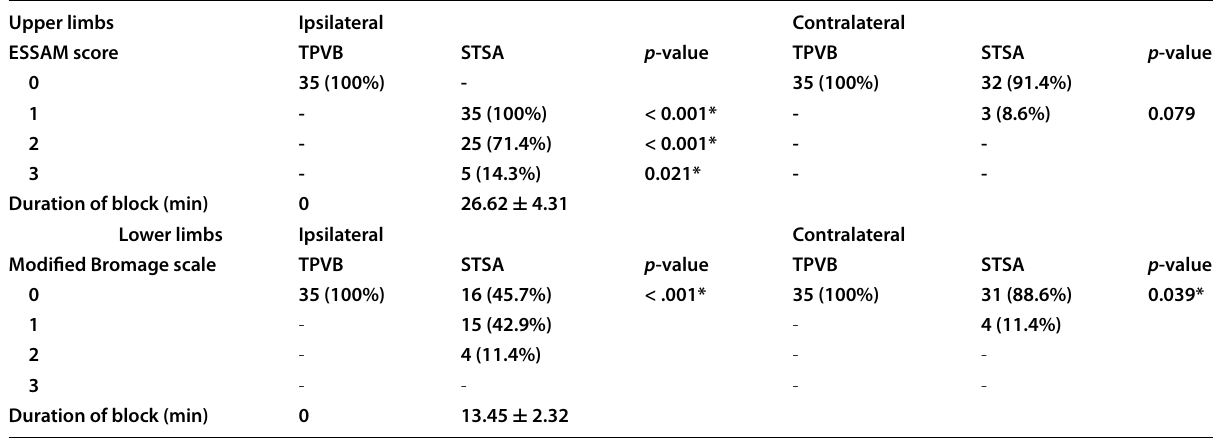
Table 4 Detailed motor block characteristics in the upper limbs (ESSAM score) and lower limbs (modified Bromage score) in both groups